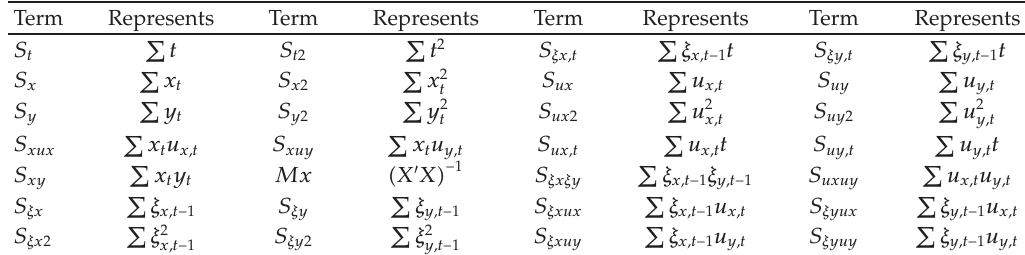
Table 2: Glossary of the Mathematica